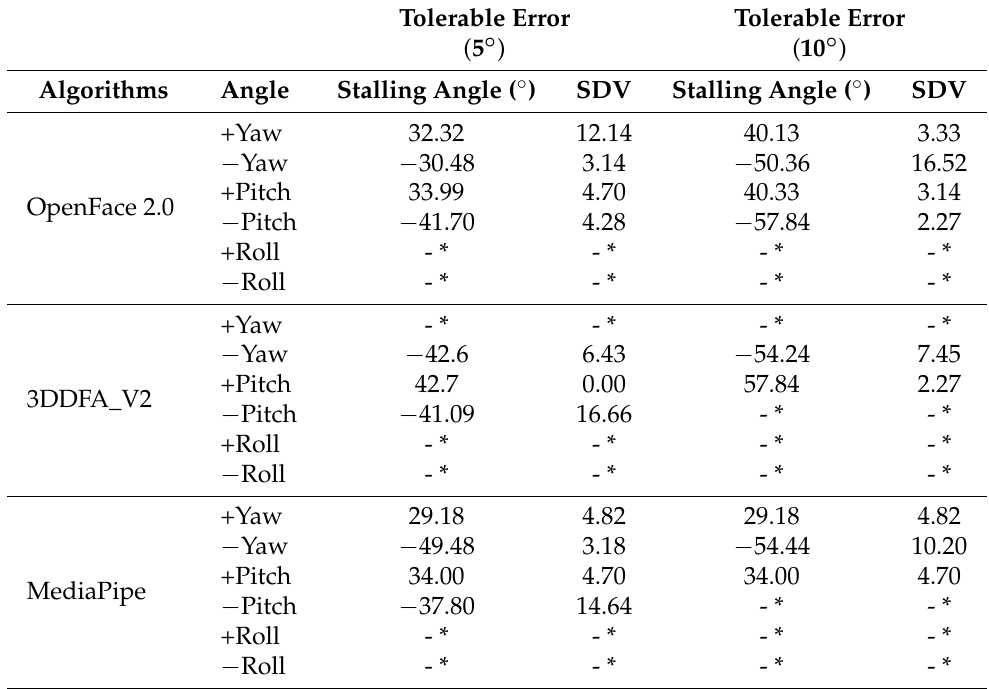
Table 3. Stalling angle per plane of motion for OpenFace 2.0, 3DDFA_V2 and